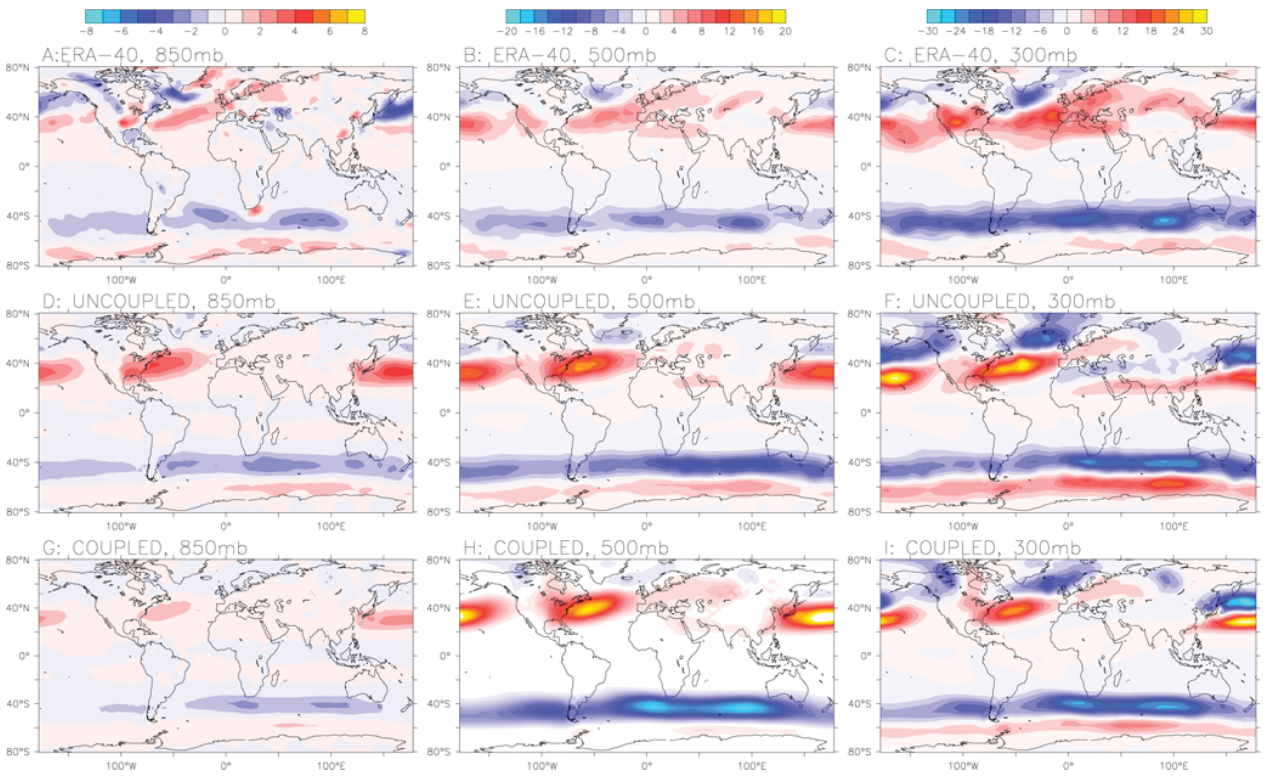
Fig. 5. Band-pass filtered ERA-40 data at (a) 850mb, (b) 500mb and (c) 300mb of h u 0 v 0 i (in m 2 s − 2 ) for December-January-February. (d–f) show results of “uncoupled” and (g–i) “coupled” experiments using Aeolus (Eq. 2) at same pressure